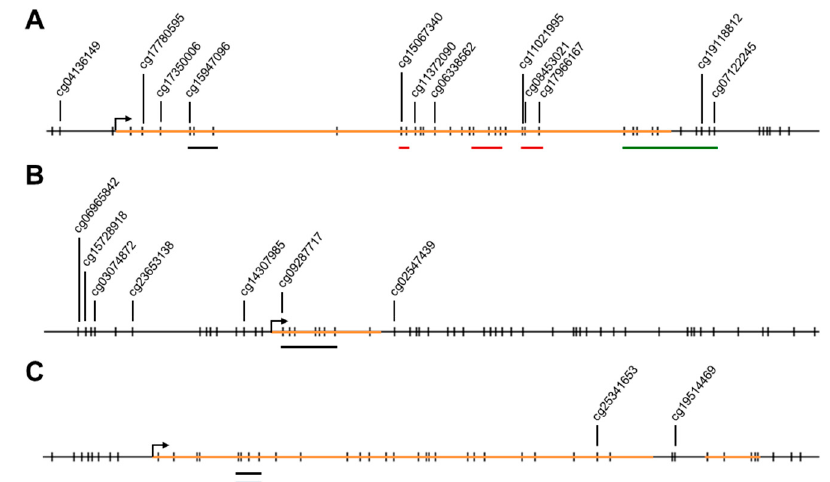
Figure 2. Overview of the CpG sites analyzed for each of the ELMO promoters in this and previous studies. The displayed regions each corresponds to 600 bp. Vertical bars represent CpG sites. CpG sites, which have Illumina CpG loci IDs (cg#) are indicated. The orange horizontal lines represent exons. Black bars underline the CpG sites studied here. Red bars underline the CpG sites studied in [25]. The green bar underlines the CpG sites studied in [34]. The blue bar underlines the CpG sites studied in [8]. ( A ) ELMO1 ; ( B ) ELMO2 ; ( C ) ELMO3 .